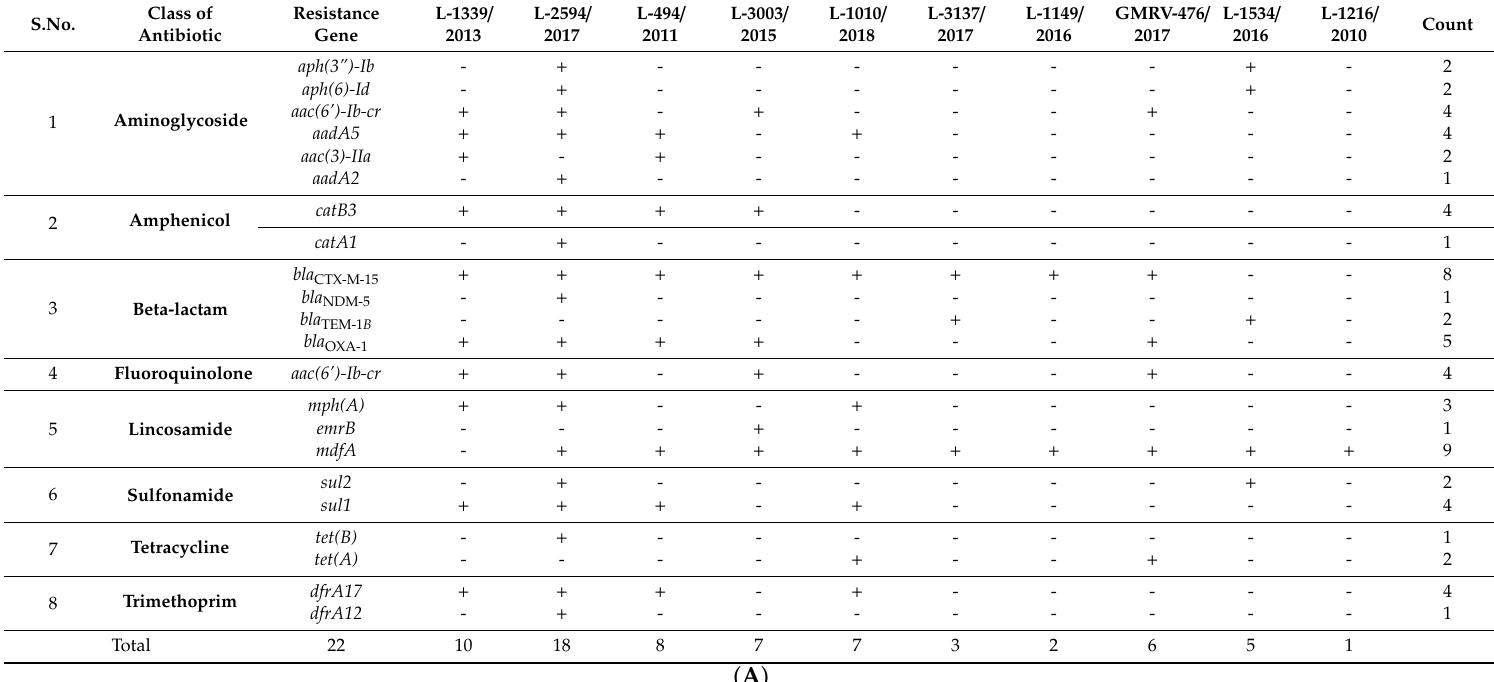
Table 2. ( A ) Identification of antimicrobial resistance genes in 10 ocular E. coli * isolates; ( B ) Chromosomal mutations in parE , gyrA , and parC in the 10 ocular E. coli isolates conferring resistance to naldixic acid and